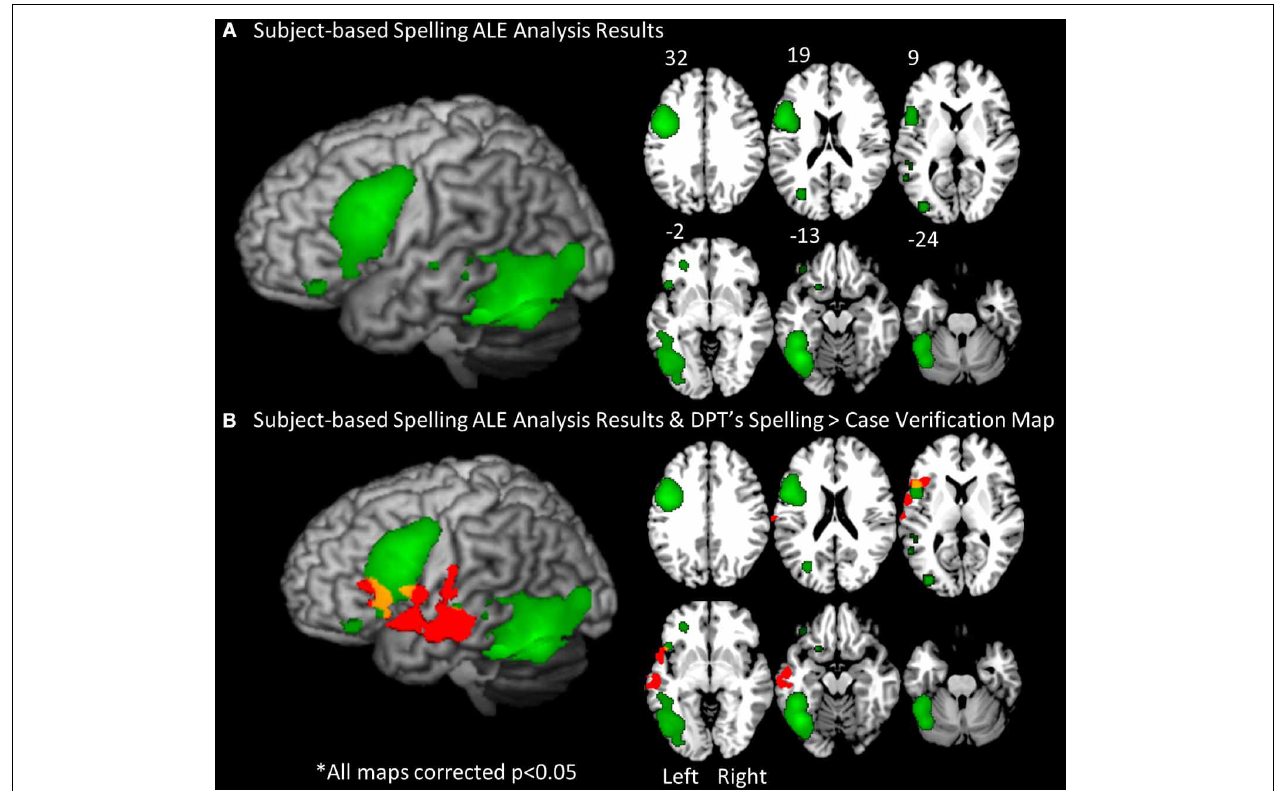
FIGURE 4 | The subject-based ALE analysis map. (A) The results of the subject-based ALE analysis based on the locations of significant spelling peaks from every control participant (19 total). ALE clusters were FDR corrected at p < 0 . 05. Significant clusters were projected on a standard rendered template brain in green. These clusters correspond